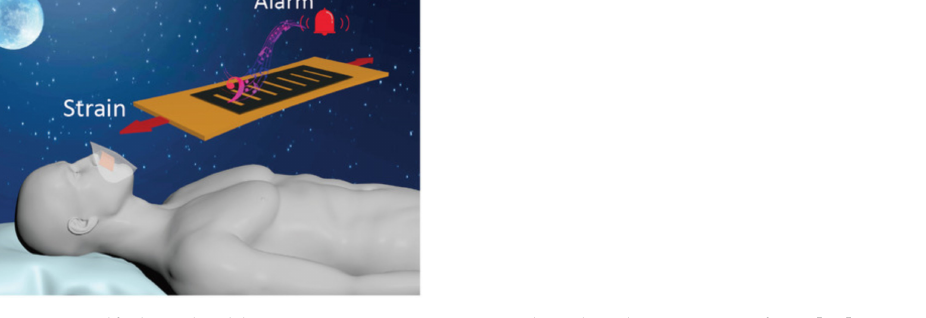
Figure 3. Self-alarm health-monitoring system. Reproduced with permission from [14]. Copyright 2019